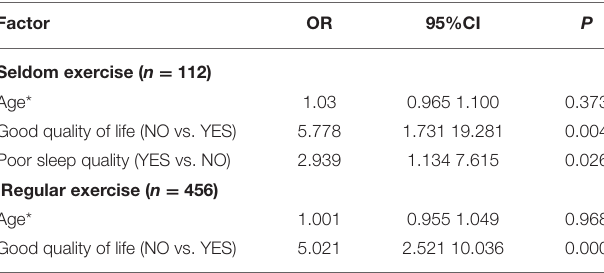
TABLE 3 | Multivariate analysis of related influencing factors of severe loneliness among the elderly in terms of physical activity.